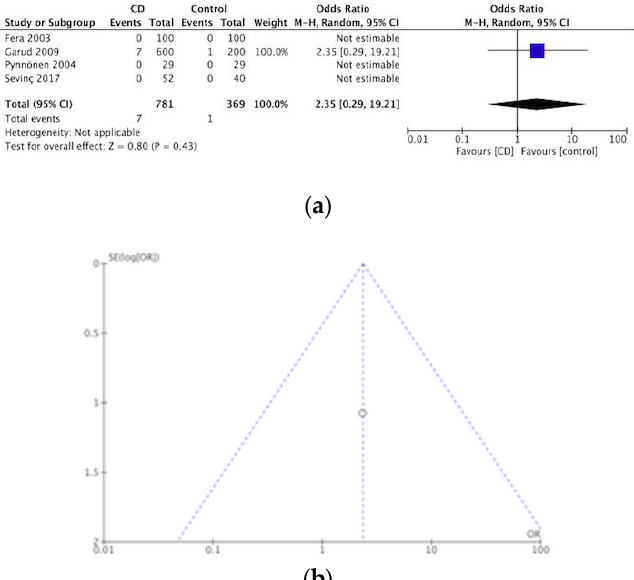
Figure 6. ( a ) Forest plot of pooled prevalence of bipolar disorder in CD. ( b ) Funnel plot investigating distribution in bipolar disorder studies.